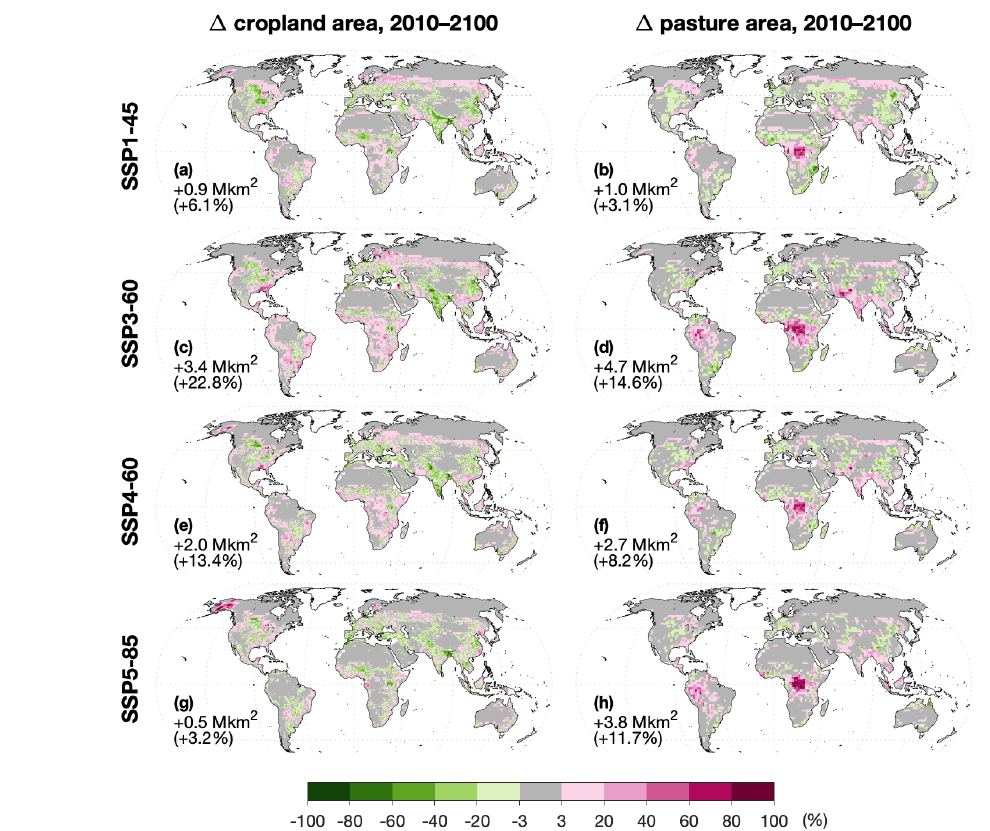
Figure 3. (a, c, e, g) Change in cropland area (as fraction of grid cell) from 2010 (LUH2) to 2100 (harmonized PLUM) under each SSP-RCP scenario. (b, d, f, h) As the left column but for